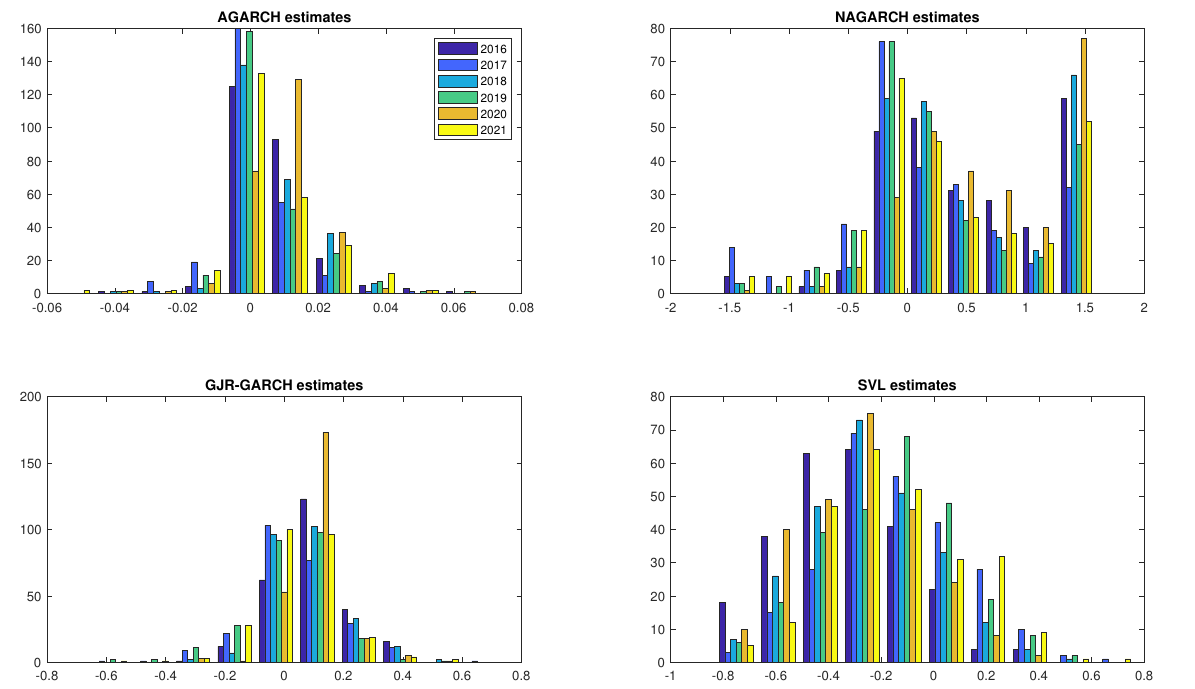
Figure 6. The figure shows the estimated coefficients of asymmetric effect models AGARCH, NA- GARCH, and GJR − GARCH and the leverage effect model SVL. Source: Authors’